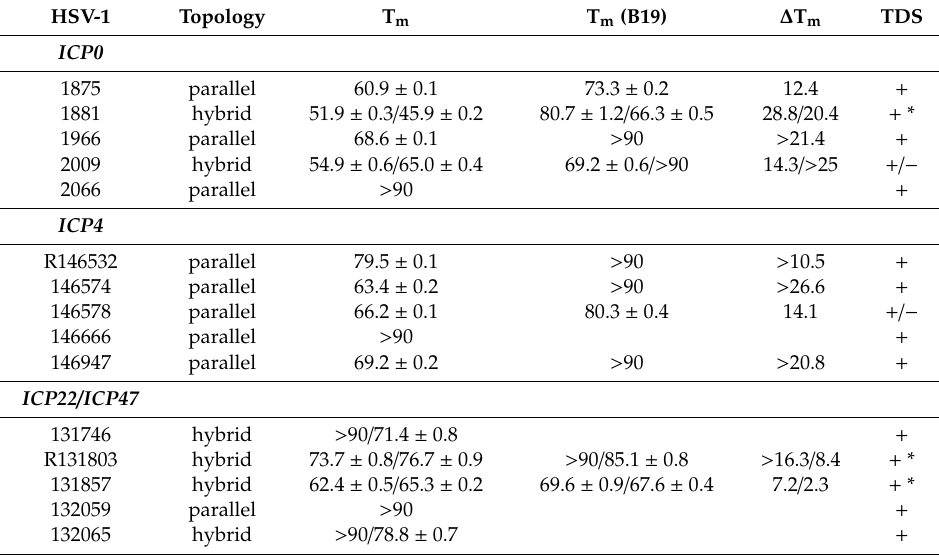
Table 4. CD and Thermal Di ff erence Spectra (TDS) analysis of PQS embedded in the Alphaherpesvirus IE promoters. Both analyses were performed at 100 mM KCl. Topology and T m values in the presence and absence of B19 are reported. For mixed structures, T m values were calculated at both 260 and 290 nm. n.a.: oligonucleotide not available due to its too high G